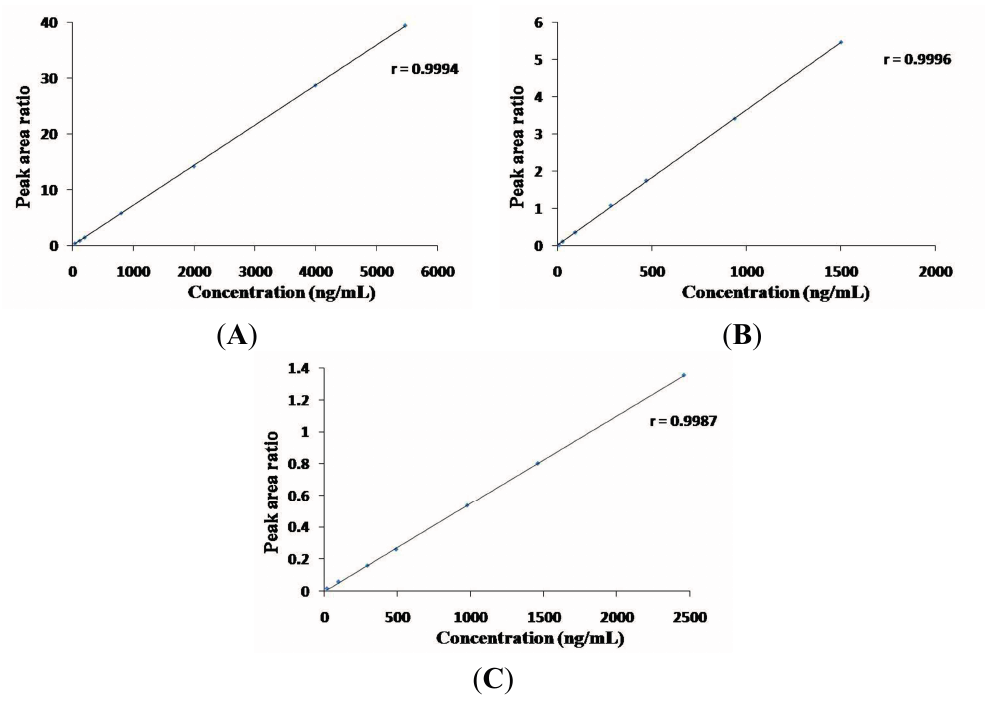
Figure 3. Linearity of representative compounds (chlorogenic acid ( A ); swertiamarin ( B ) and schaftoside ( C